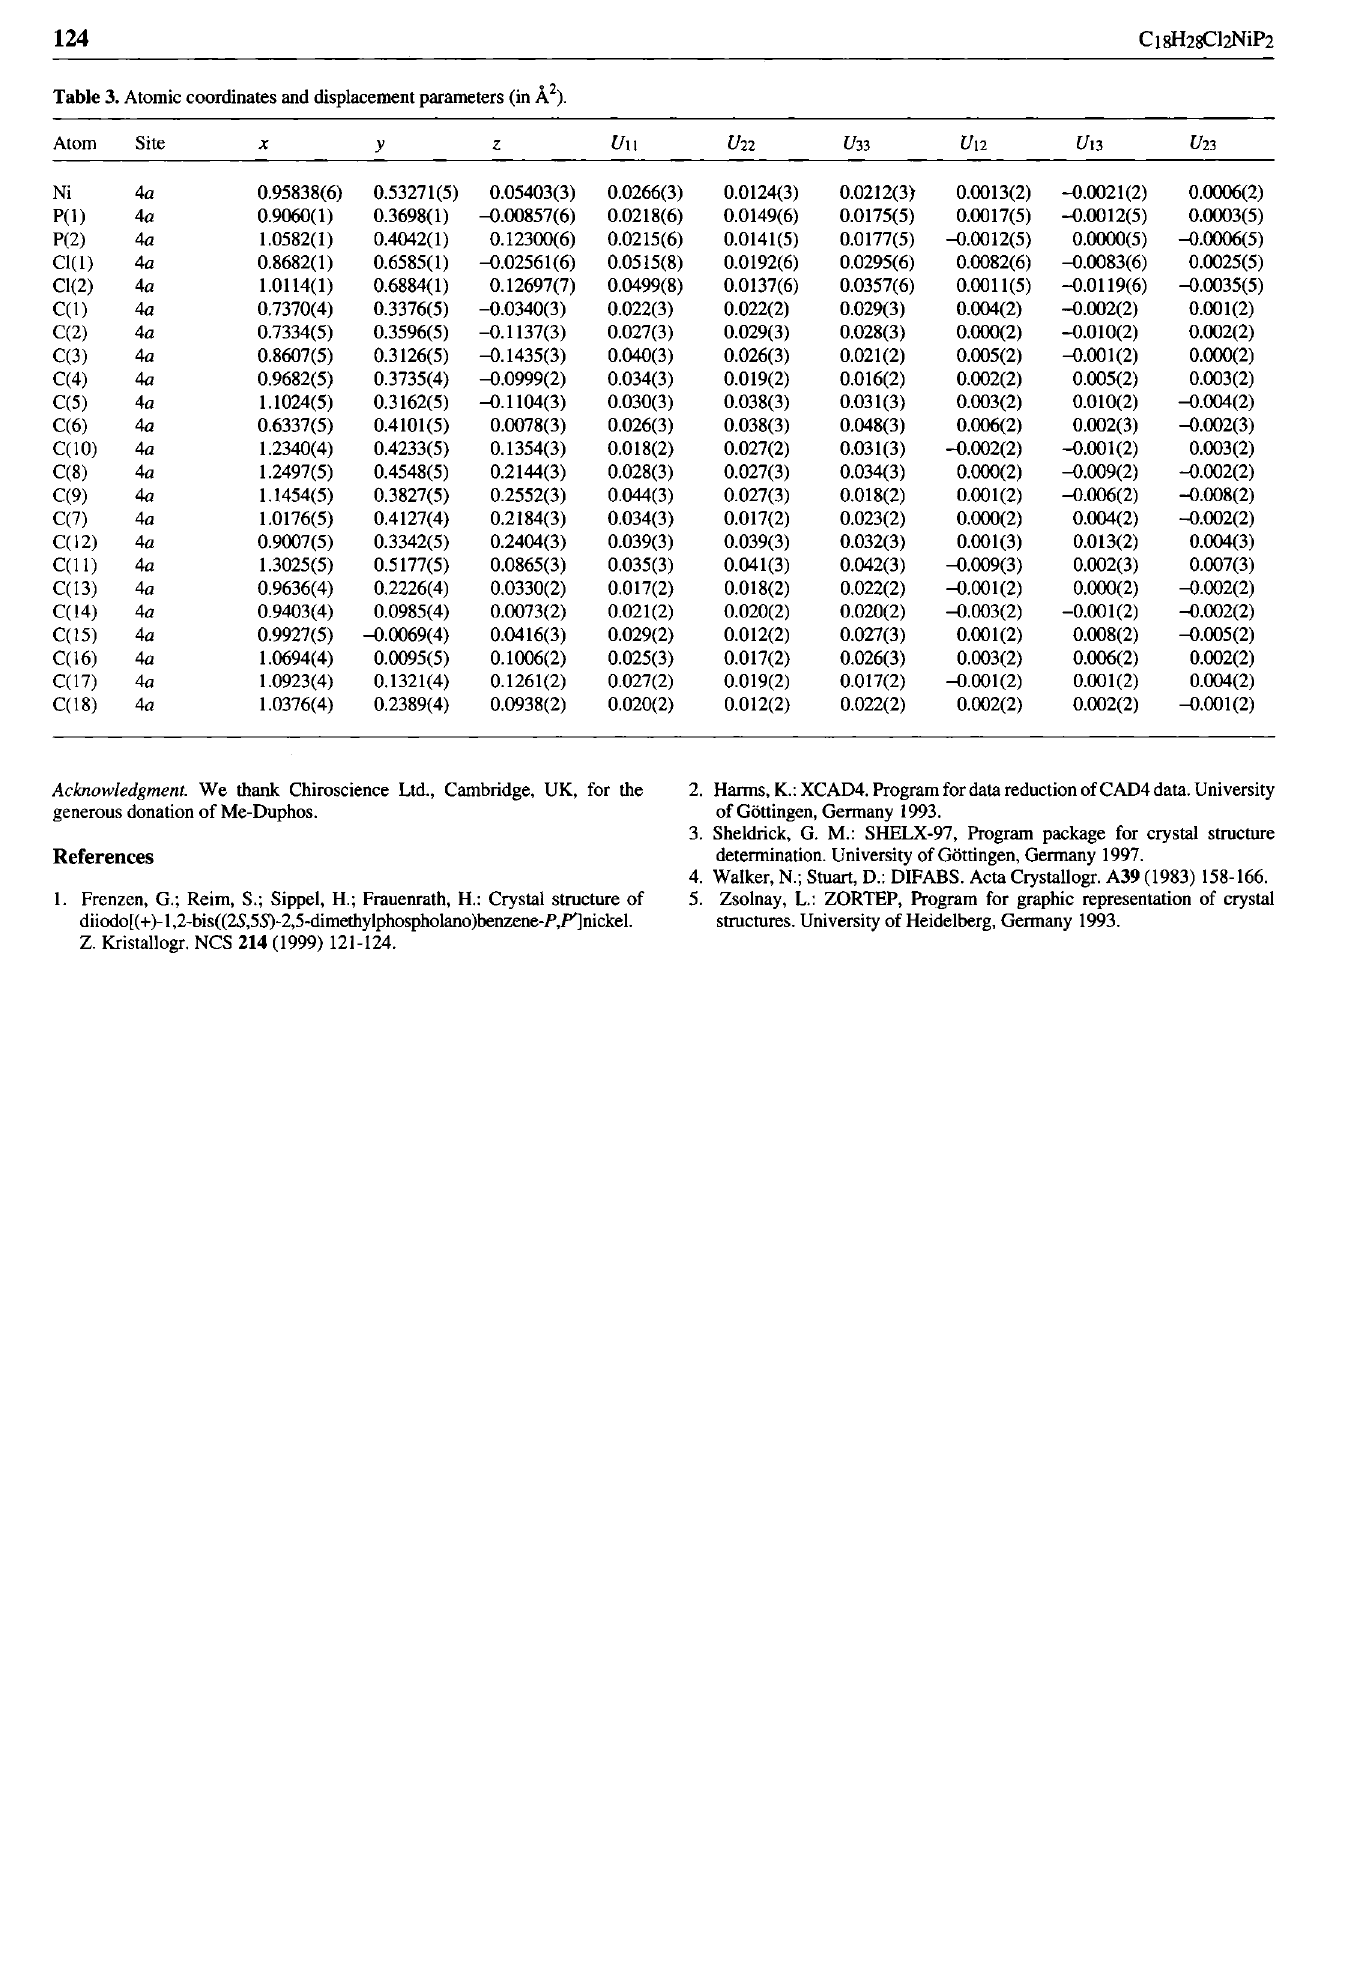
Table 3. Atomic coordinates and displacement parameters (in Â 2